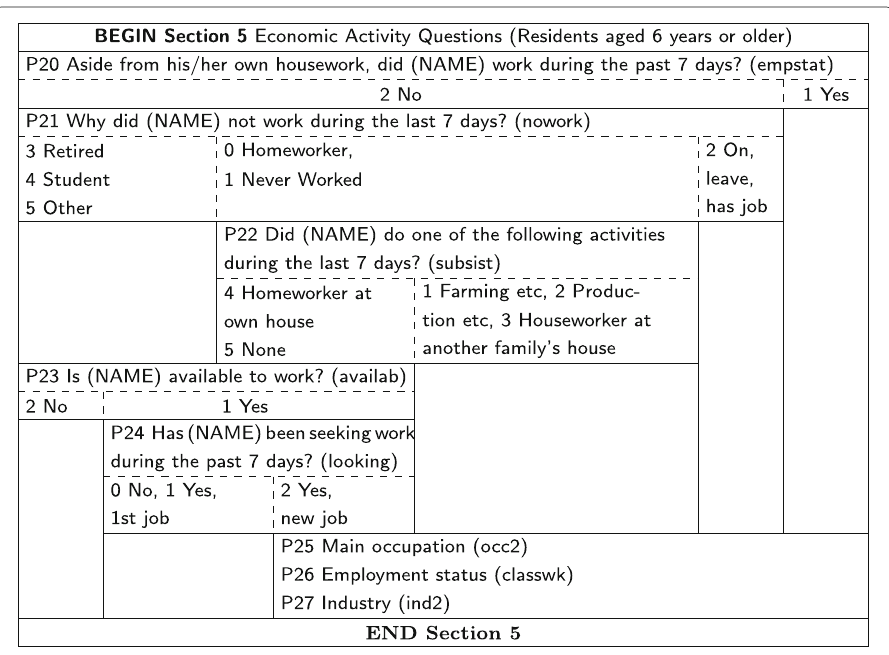
Fig. 3 Nassi-Shneiderman diagram Malawi 2008 census economic activity questions. Each interview traces a path through the blocks comprising the diagram, from top to bottom, with paths crossing horizontal lines only. IPUMS-assigned variable names are shown in parentheses following the questions. Compare the visualization in Fig. 2a